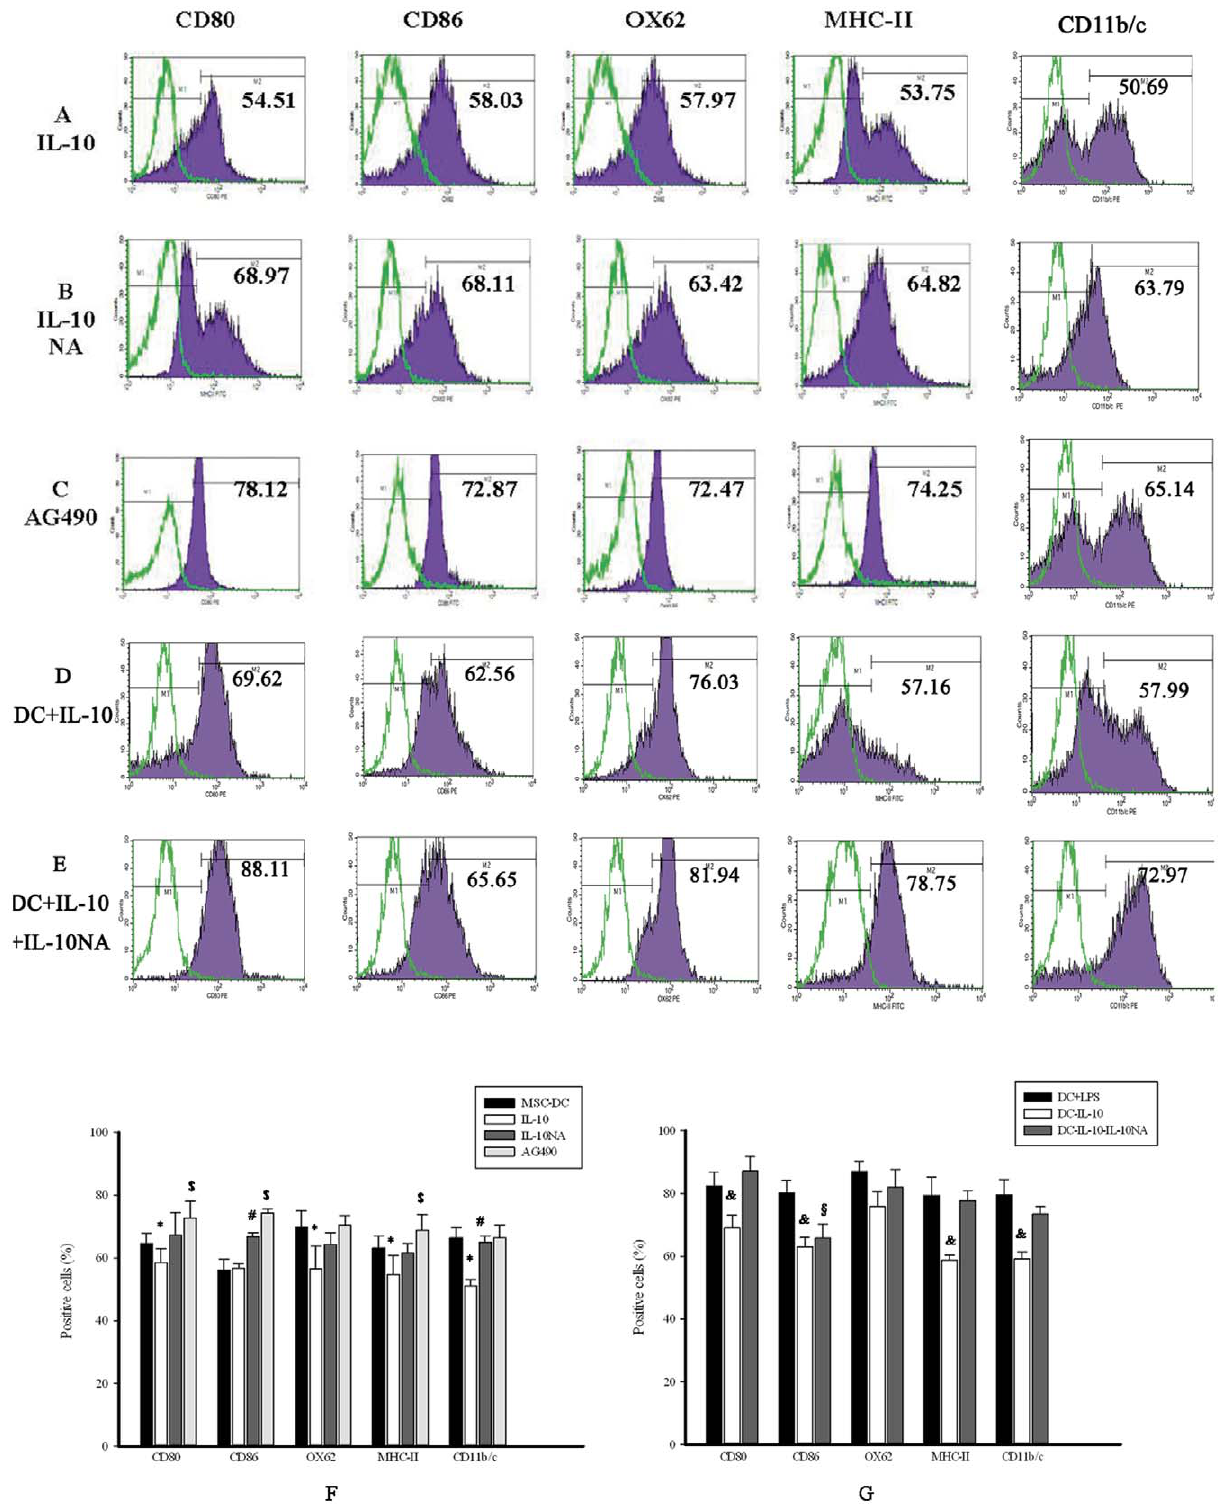
Figure 7. DCs surface markers (CD80, CD86, OX62, MHC-II and CD11b/c) in the MSC-DC co-culture system (ratio MSC:DC of 1:10) supplemented with exogenous: (A) IL-10; (B) IL-10NA and (C) AG490. (D, E) These makers expression in DC-IL-10 and DC - IL-10 - IL-10NA group by FACS. (F, G) Quantification by image analysis of the positive cells. Numbers in the histograms indicate the mean fluorescence of each DCs markers. *P , 0.05(IL-10 group versus MSC-DC group), # P , 0.05(IL-10NA group versus MSC-DC group), $ P , 0.05(AG490 group versus MSC-DC group).